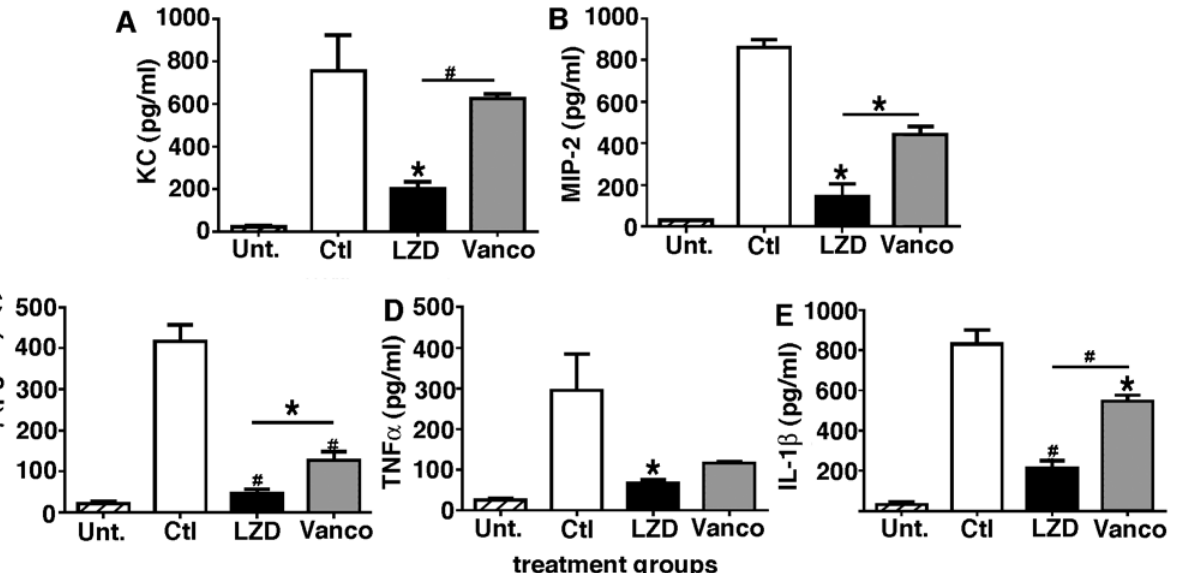
Figure 4. Mice treated with LZD have significantly lower chemotactic chemokines as well as inflammatory cytokines in BAL post bacterial challenge. WT mice were infected with H1N1 100 pfu i.n. and on day 7 challenged with 5×10 7 cfu cMRSA i.t., infected mice were treated with either vehicle or antibiotics LZD (80mg/kg i.p.) or Vanco (110 mg/kg i.p.). BAL was performed 24 hours post bacterial challenge and chemokine/cytokine protein levels measured by ELISA.). n = 6 in each group, experiment repeated twice. * p < 0.05, #p < 0.01 as compared to vehicle treated group. Error bars represent mean (cid:2) SEM.